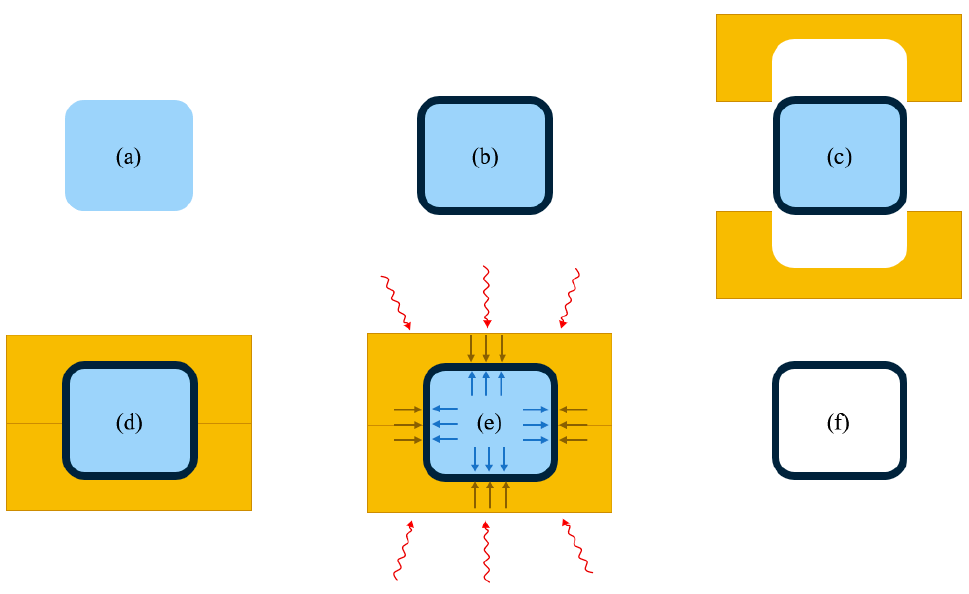
Figure 2. Schematic of trapped rubber processing (TRP) in a simplified cross-section view: ( a ) initial rubber section, ( b ) preform construction, ( c ) clamshell cavity mold, ( d ) processing mold assembly, ( e ) heating and pressure cycle, ( f ) demolding.